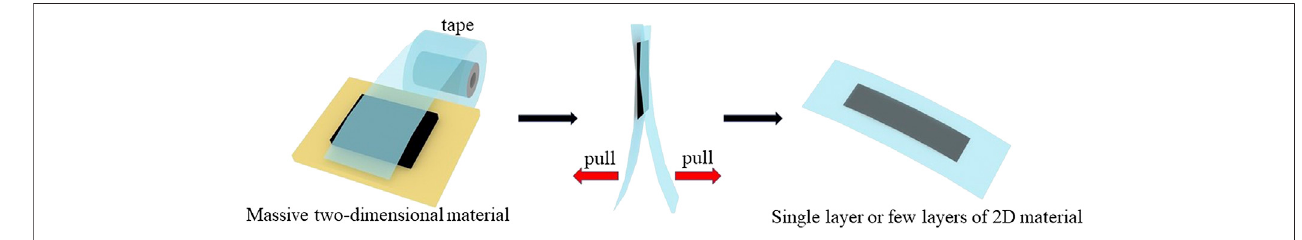
FIGURE 5 | Flow chart of two-dimensional material mechanical exfoliation